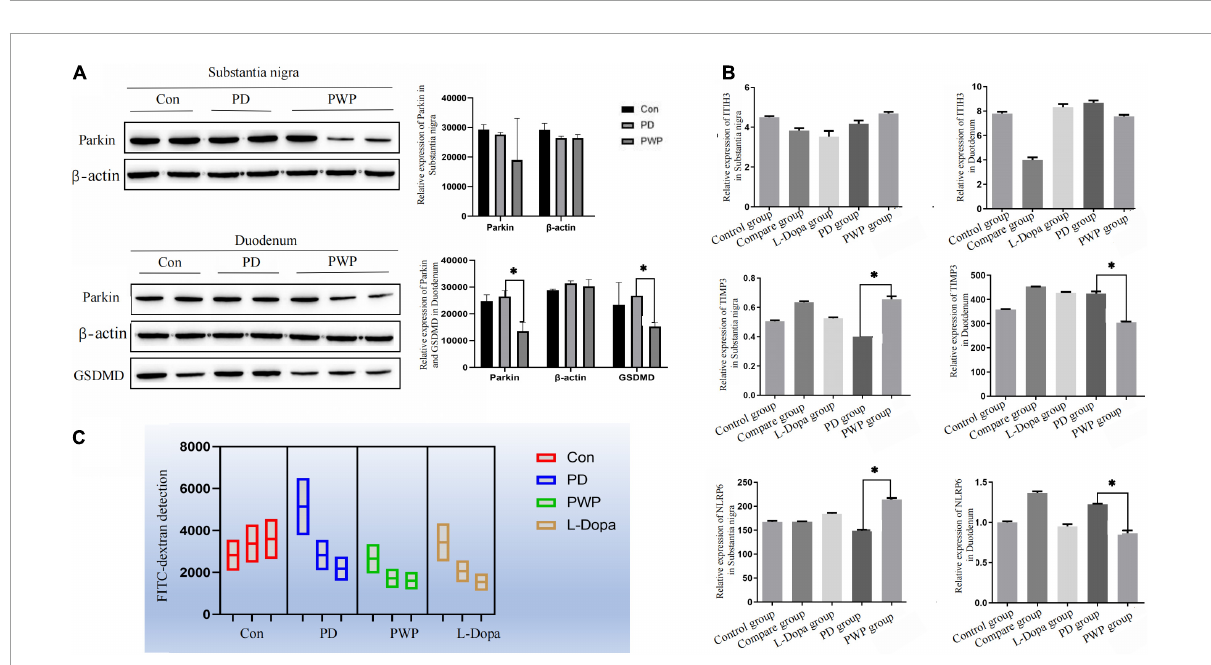
FIGURE10 The result of protein expression in Brain and gut by WB and ELISA, as well as FITC-dextran concentrations test. (A) WB showing the expression of Parkin, and GSDMD in the substantia nigra and duodenum. (B) ELISA results showing the expression of TIMP3, NLRP6, and ITIH3 in the substantia nigra and duodenum. (C) FITC-dextran concentrations test in the control, PD, L-Dopa therapy, compare and PWP groups. *Means that p < 0.1 for significant differences.